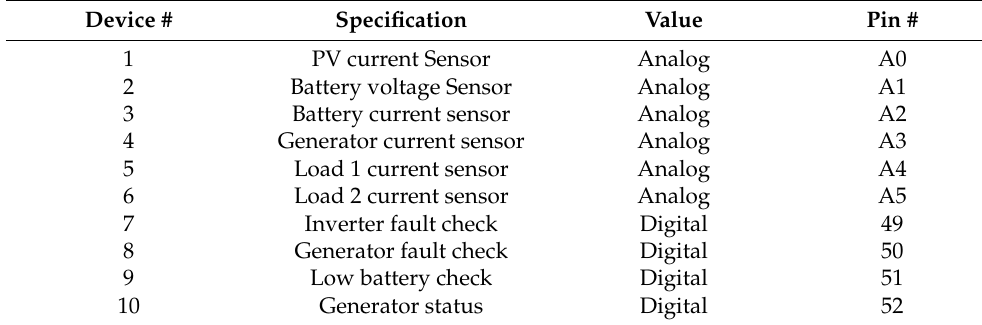
Table 6. The Arduino interconnections with sensors, LEDs, and